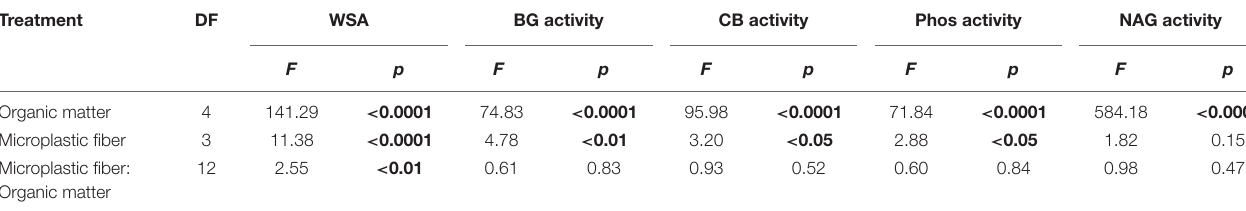
TABLE 1 | ANOVA results for the effects of organic matter, microplastic fibers, and the interaction of these factors on the stability of soil aggregates (WSA), β -Glucosidase (BG) activity, cellobiohydrolase (CB) activity, phosphatase (Phos) activity, and N-acetyl-glucosaminidase (NAG) activity. Treatment DF